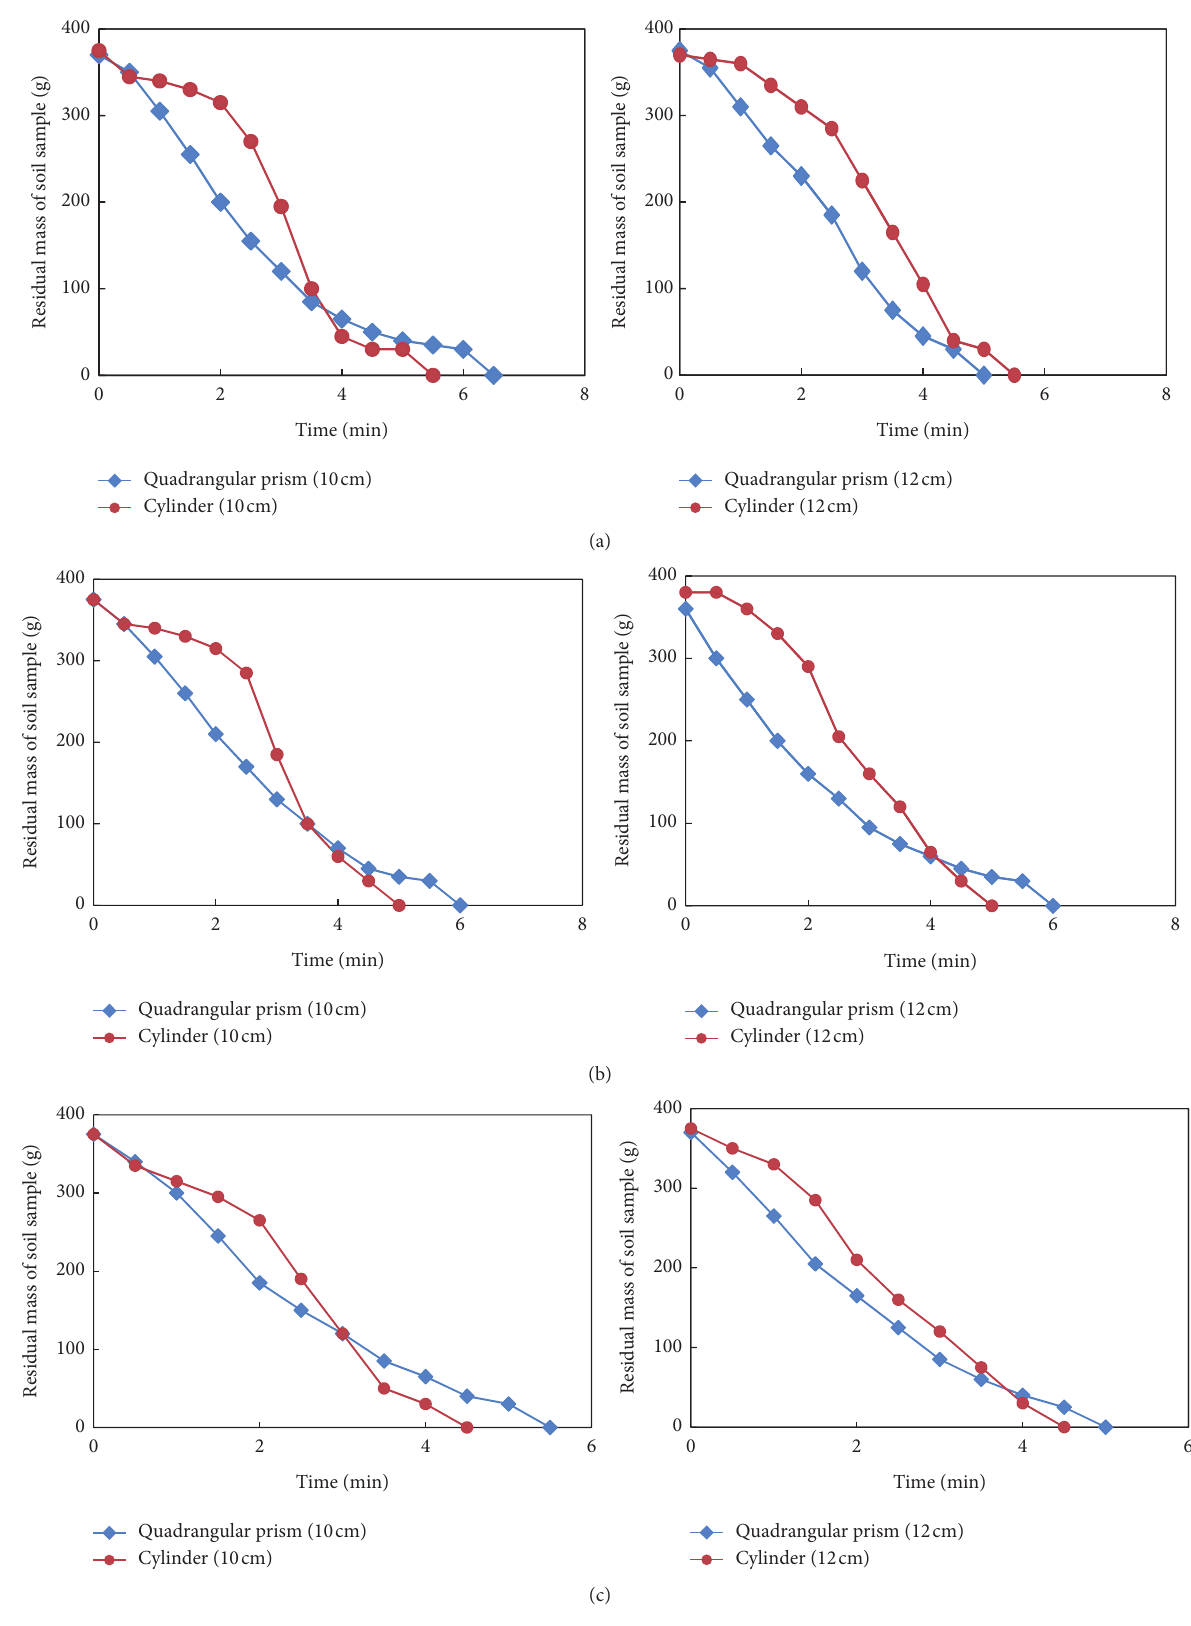
Figure 4: Disintegration curve of soil samples with the same volume and different shape, (a) − 18cm, (b) − 30 cm, (c) −